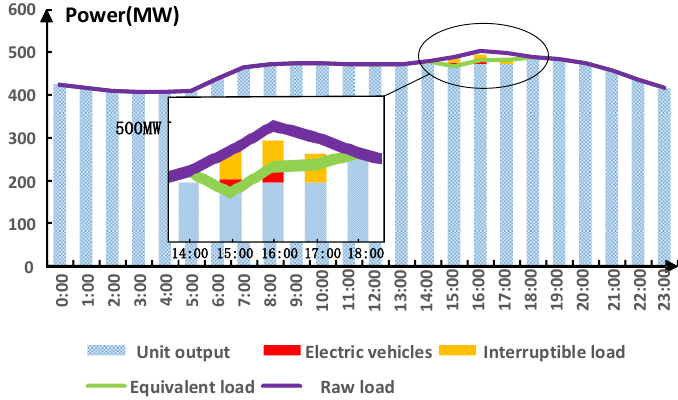
Table 7. Loss of energy probability. Figure 6. System operation status before and after demand response.